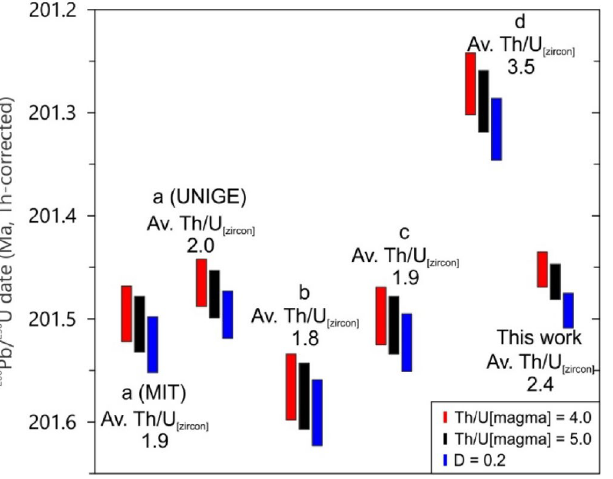
Figure 4. 206 Pb/ 238 U weighted mean ages for the NMB03 sample using different Th/U [magma] correction values. (a)—Ref. 4 , (b)—Ref. 6 ; (c)—Ref. 2 ; (d)—Ref. 10 and this work. Note that depending on the Th/U [zircon] value (expressed as average) and the weighted mean age error, a different correction may imply in discordant ages for the same analysis. Ages from Ref. 4 were also recalculated from previous EARTHTIME tracer calibration based on the corrections made by Ref. 7